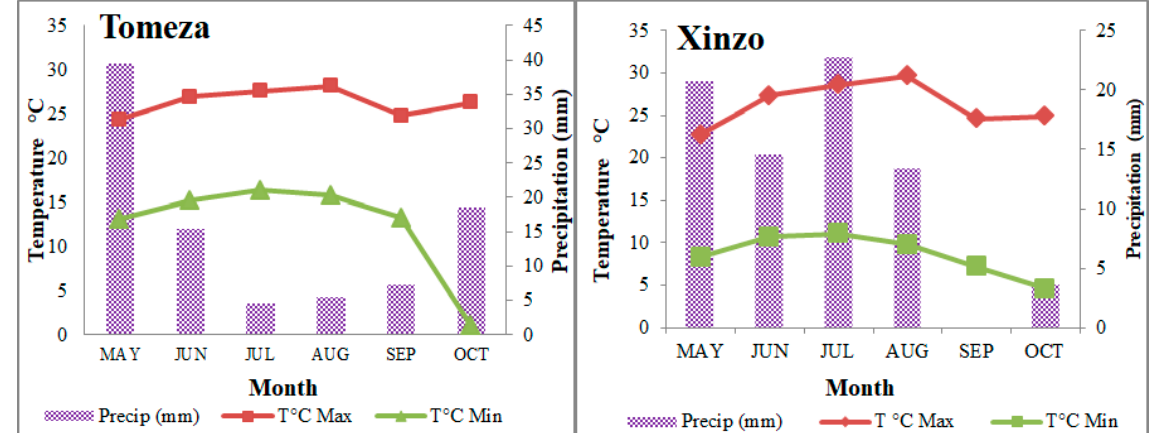
Figure 1. Meteorological conditions during the experimental season in both locations used in this study.